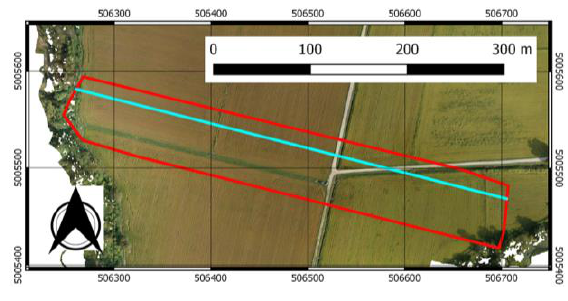
Figure 4. East-West profile in the overlapping area